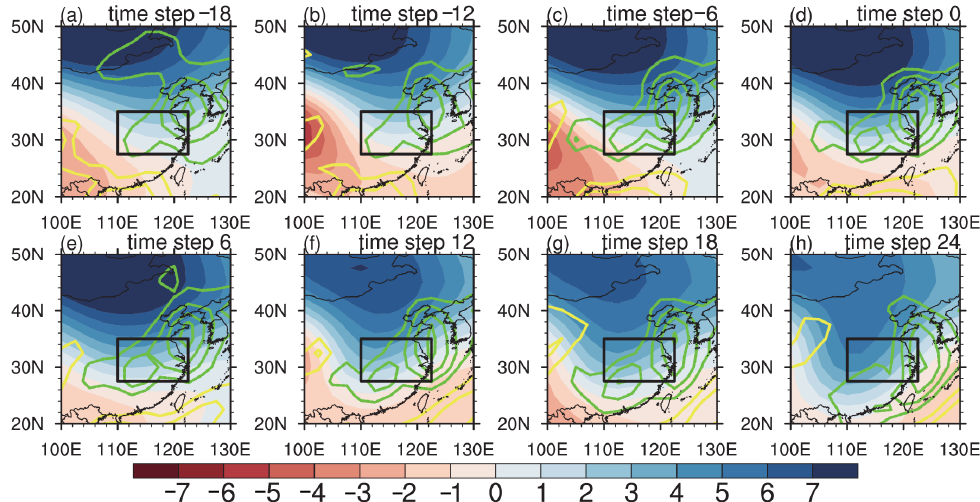
Figure 9. Evolution of SLP anomalies (colors, hPa) and surface meridional wind anomalies (contours, m / s; northerly wind anomalies are in green and southerly wind anomalies are in yellow) with respect to winter climatology at time steps ( a ) –18, ( b ) –12, ( c ) –6, ( d ) 0, ( e ) 6, ( f ) 12, ( g ) 18, and ( h ) 24 for the ISEs in the YRV region. Atmosphere 2019 , 10 , x FOR PEER REVIEW the NC and YRV regions, the synoptic evolution in the anomalies of areal mean surface meridional